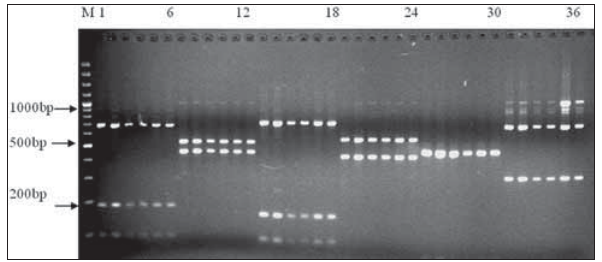
Figure-2: Screening of mitochondrial cytochrome b of sheep pooled DNA revealed by four restriction